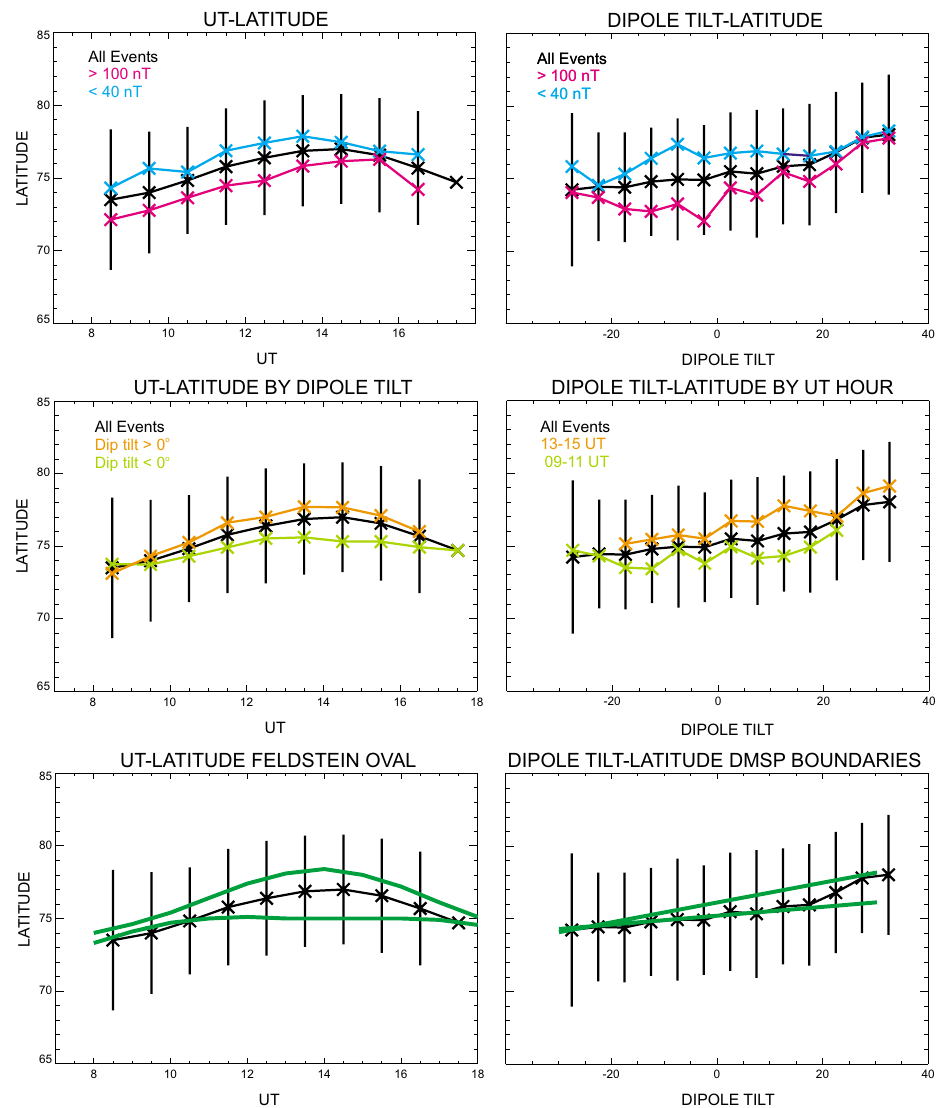
Fig. 13. Mean latitude of events are shown as functions of UT-time of events (left panels) and dipole tilt-angle (right panels). In all panels, black crosses and error-bars (standard deviation) present the results for the full set of events. In the top two panels, magenta crosses are for the subgroup of large amplitude events and cyan crosses are for the small amplitude events. In the middle left panel, orange crosses present the results for the 1776 events that have positive dipole tilt-angle and the green crosses present the 1260 events with negative dipole tilt-angle. In the middle right panel, orange crosses present the results for 620 events occurring between 13:00 and 15:00 UT while the green crosses are for the 762 events that occur between 09:00 and 11:00 UT. In the bottom left panel, green curves mark the location of poleward and equatorward boundaries of the statistical Feldstein oval for Q = 0 and MLT = UT − 2. In the bottom right panel, green curves mark the statistical location of the equatorward boundaries of the Cusp and LLBL for 11:00–13:00MLT as determined from DMSP particle precipitation